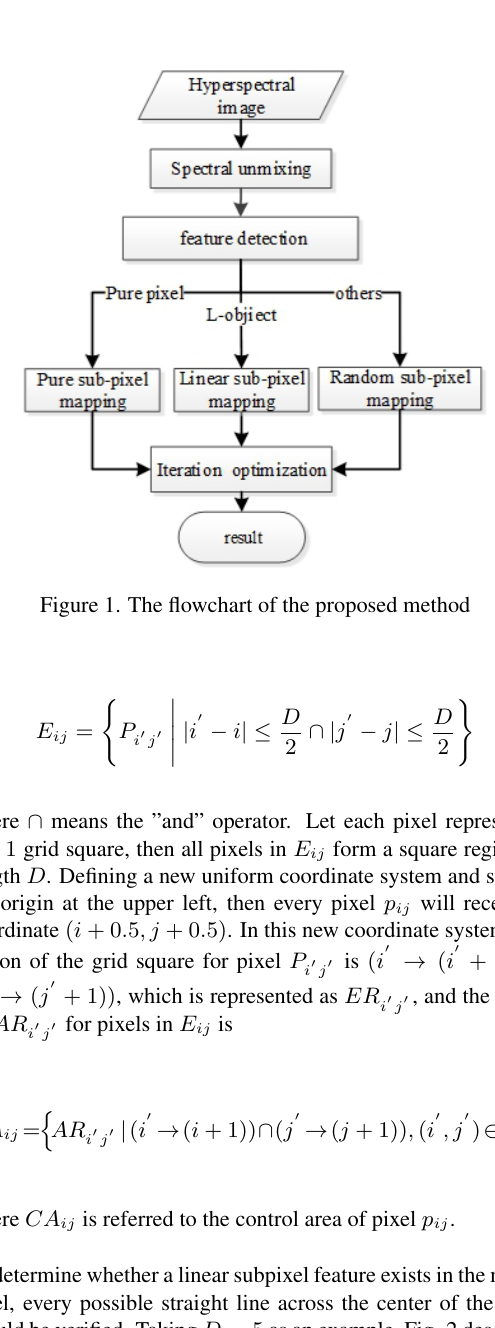
where β 0 , 0 = β 1 , 1 = · · · = β D are removed, the total number of lines is p = ( D +1) 2